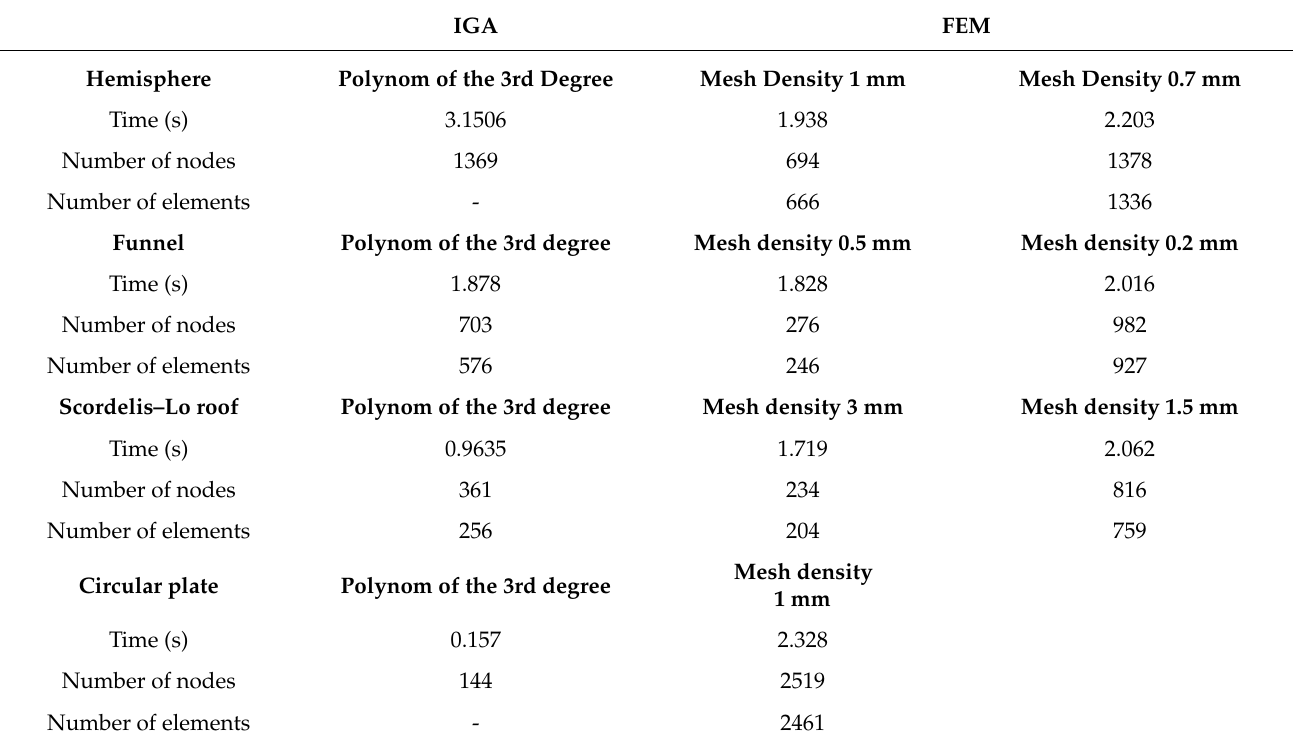
Table 5. Comparison of mesh parameters and solution